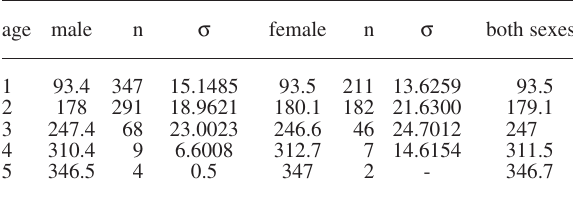
T ABLE 1. – Back-calculated fork lengths (mm) of males and females of Balistes capriscus , from the southeastern coast of Brazil; n: number of fish specimes; σ : standard